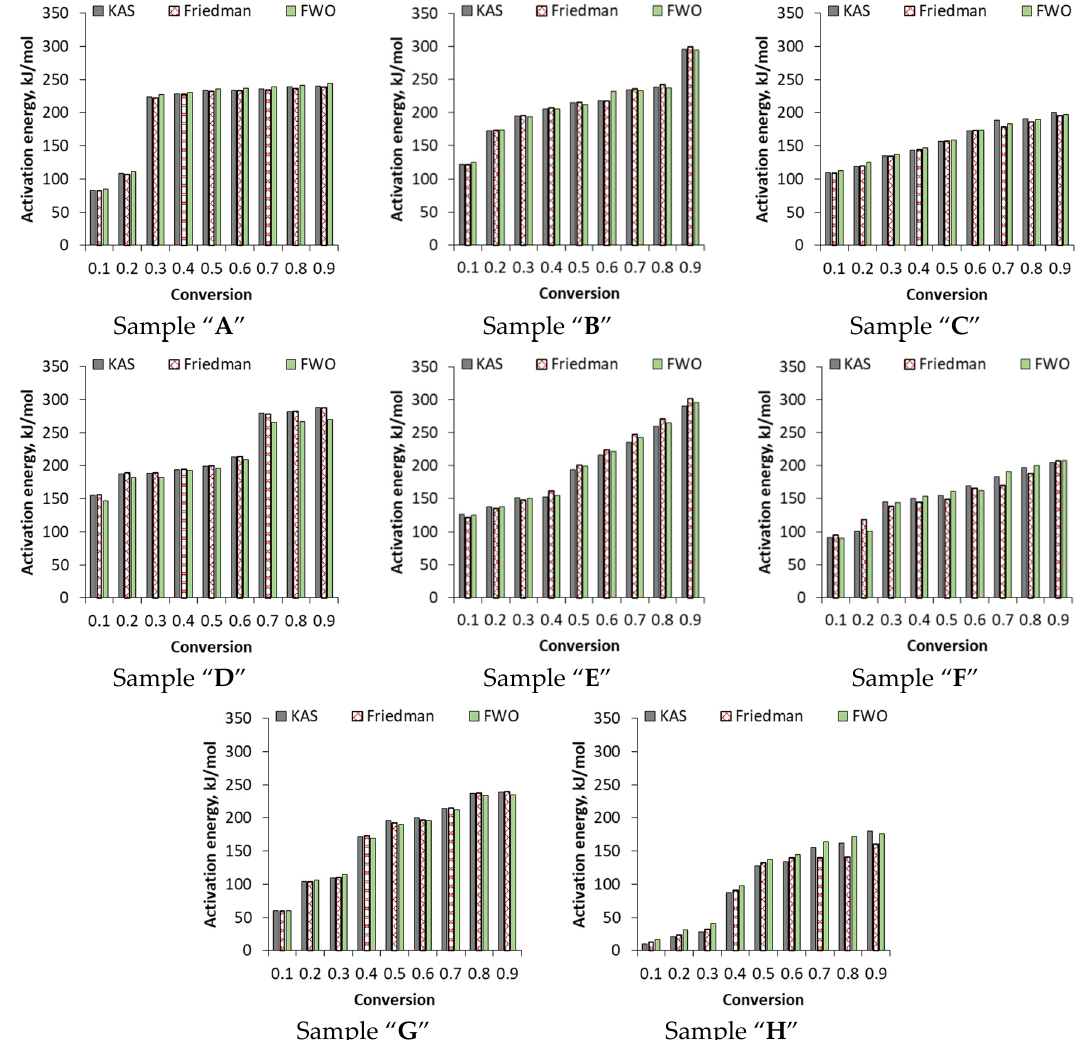
Figure 6. Activation energies calculated by the KAS, Friedman and FWO methods.